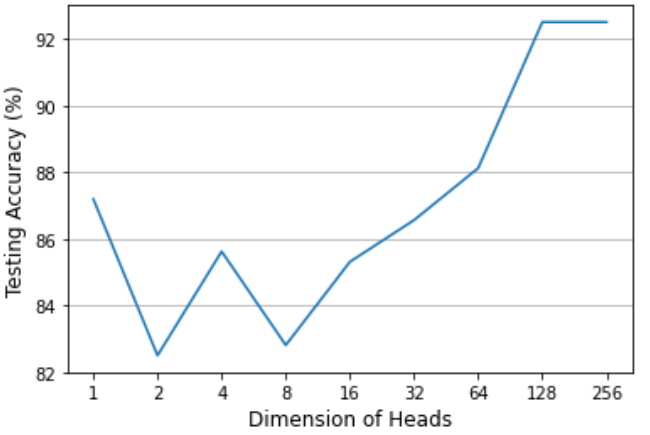
Figure 8. The influence of the number of multi-headed self-attention heads.